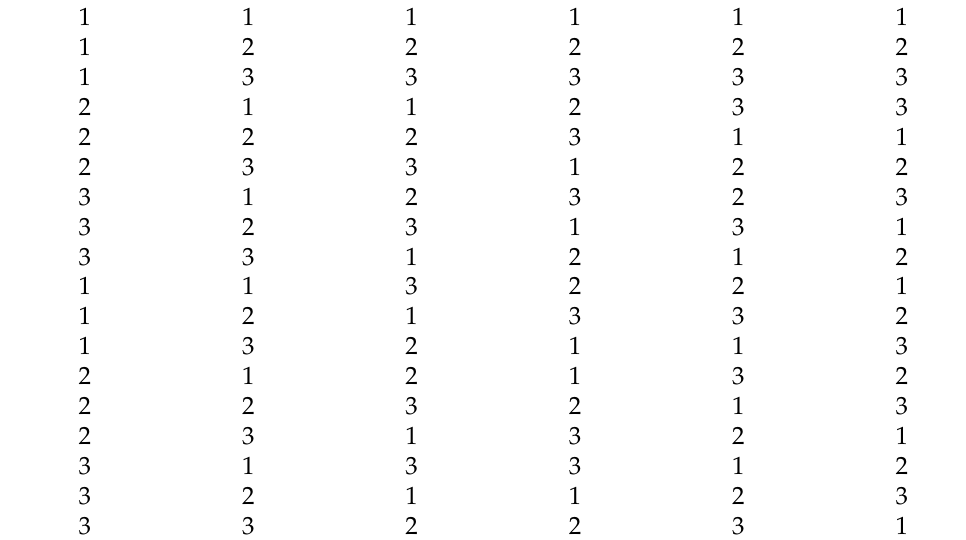
Table A6. L 18 orthogonal array.